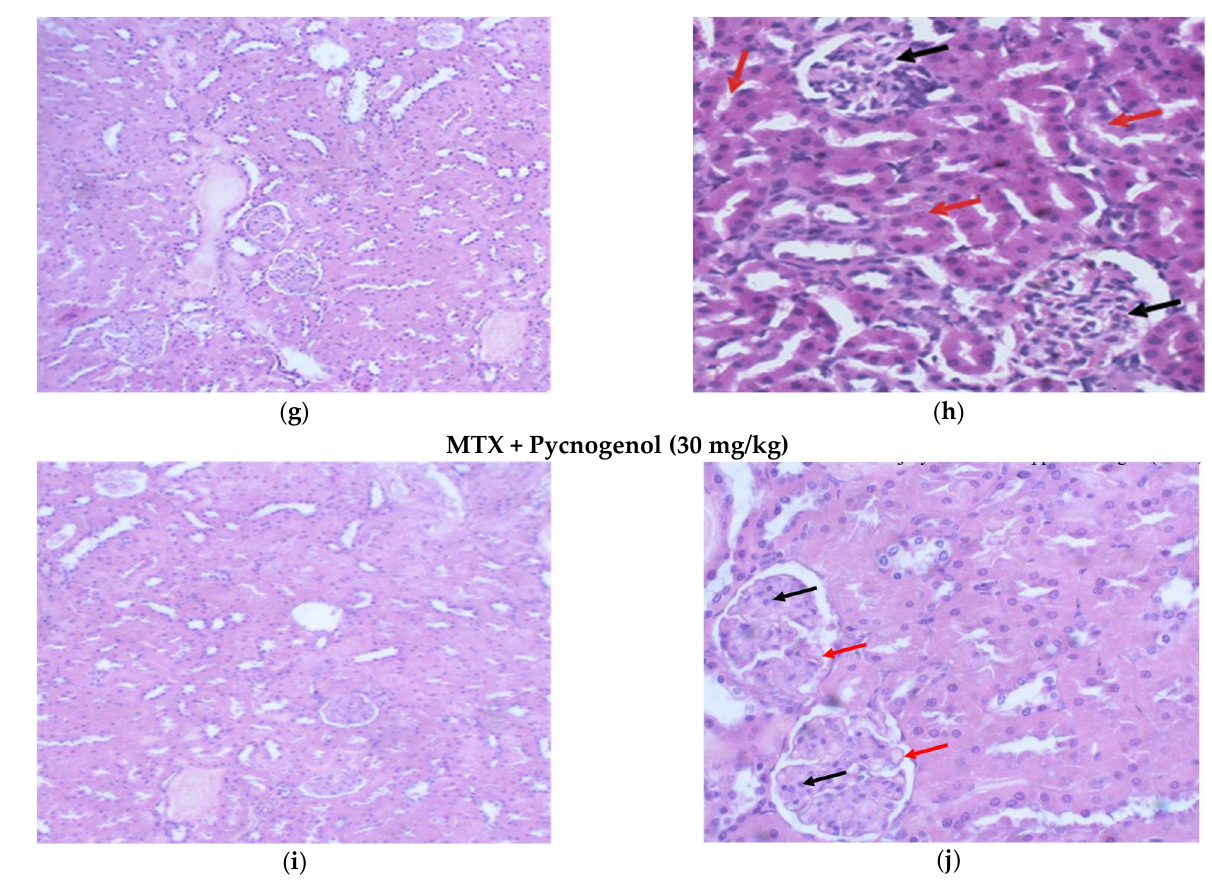
Figure 6. Photomicrograph of H&E-stained kidney sections. ( a ) Uniform kidney tissue, with regular glomeruli (black arrows), tubules (Red arrow), and densely packed interstitium with blood vessels (Arrow heads) (H&E, 10x). ( b ) Higher magnification of the previous figure showing uniform glomerular tuft, with normal wall thickness and patent capillary lumens (black arrow). Surrounding tubules reveal no signs of injury. (H&E, 40x). ( c ) Multiple foci representing more than 50% of tubules show evidence of tubular injury (black arrows) (H&E, 10x). ( d ) Tubules demonstrate evidence of acute tubular injury: disturbed tubular outline, loss of brush border, detached lining cells into lumen, cytoplasmic vacuolization, and membrane blebbing (black arrows). Glomeruli appear large due to mesangial expansion with mild thickening of the capillary wall (red arrows) (H&E, 40x). ( e ) Multiple foci representing less than 50% of tubules show evidence of tubular injury (black arrows) (H&E, 10x). ( f ) Some tubules demonstrate evidence of acute tubular injury (black arrows). Glomeruli show mesangial expansion with mild thickening of the capillary wall (red arrows) (H&E, 40x). ( g ) No evidence of tubular injury. Glomeruli appear enlarged (H&E, 10x). ( h ) Glomeruli (black arrows) showing mesangial hypercellularity. The tubules (red arrows) are tightly packed, with uniform epithelial lining and uniform cytoplasm (H&E, 40x). ( i ) No evidence of tubular injury. Glomeruli appear enlarged (H&E, 10x). ( j ) Glomeruli show mesangial expansion (arrow heads) with mild thickening of the capillary wall (red arrows). The tubules are tightly packed, with uniform epithelial lining and uniform cytoplasm (H&E, 40x).